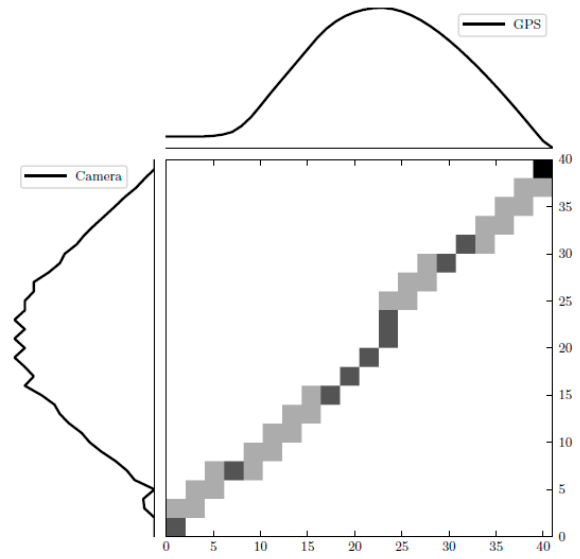
Figure 6. FDTW cost matrix of GPS-based and camera-based estimated distances time series.